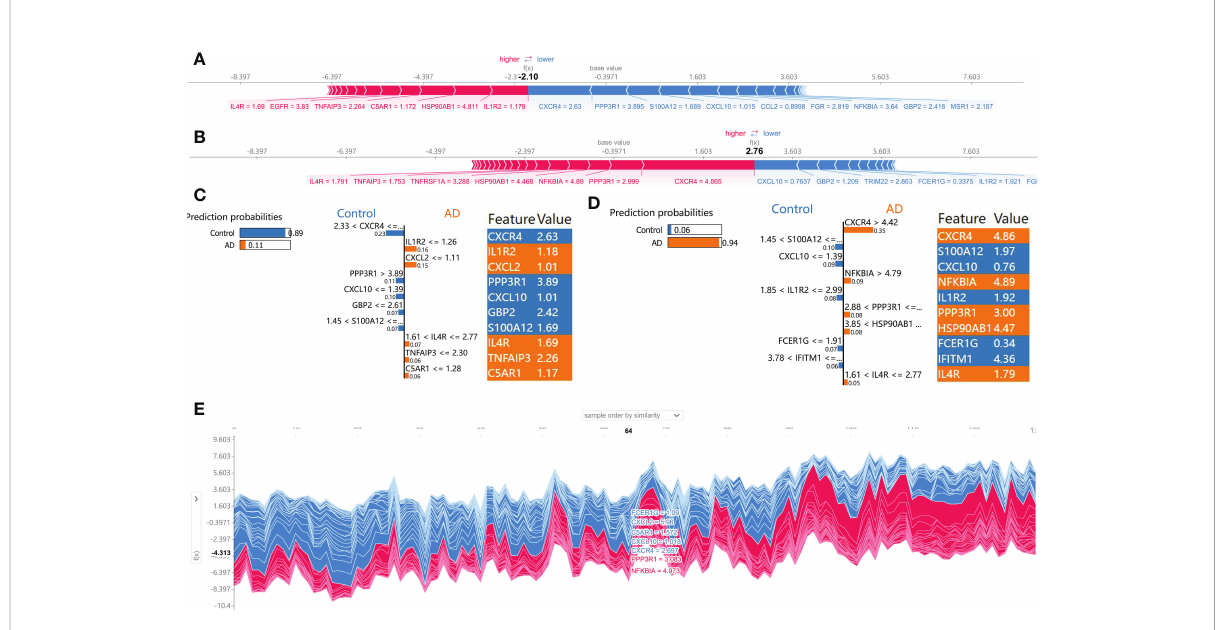
FIGURE 7 SHAP force plot and LIME algorithm for interpreting individual ’ s prediction results. (A, B) A normal individual (A) and AD case (B) were presented based on the SHAP force plot, respectively. The bars in red and blue corresponded to increased AD probability and decreased AD probability, respectively. (C, D) A normal individual (C) and AD case (D) were presented based on the LIME algorithm, respectively. The left side of the fi gure exhibited the results of the LIME predictions. The middle section lists exhibited the ten variables that have the greatest effects on normal or AD onset. The length of each feature bar indicated the importance of correspond feature in making predictions. The right panel exhibited the speci fi c values for the ten variables with the greatest effect on normal or AD onset. (E) The global explanation for all the normal and AD samples in the testing cohort were depicted based on the SHAP force